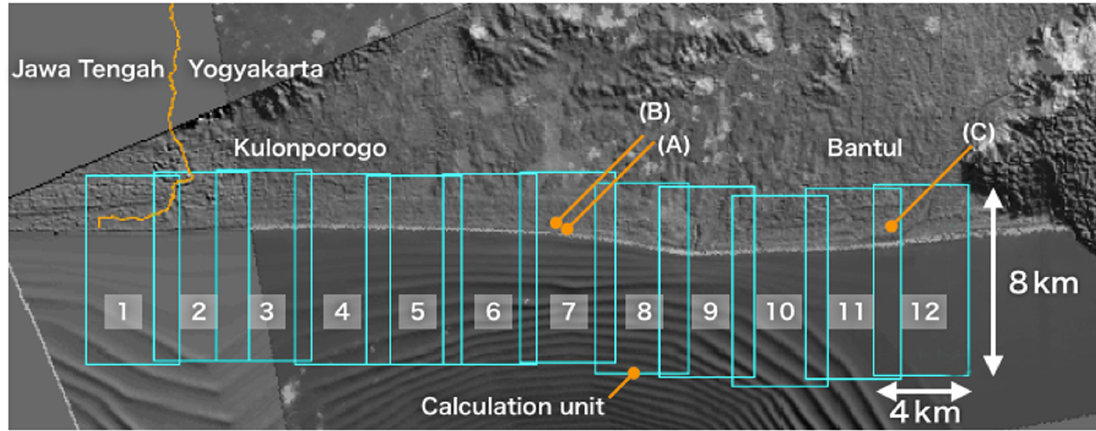
Fig. 7. Configuration of calculation units and the verification points (A), (B) and (C). hydraulic drag with trees (Table 1). The tree canopy sizes were averaged values of the field records on each land cover class and a 0.97 porosity of tree canopy was applied (Harada and Imamura,